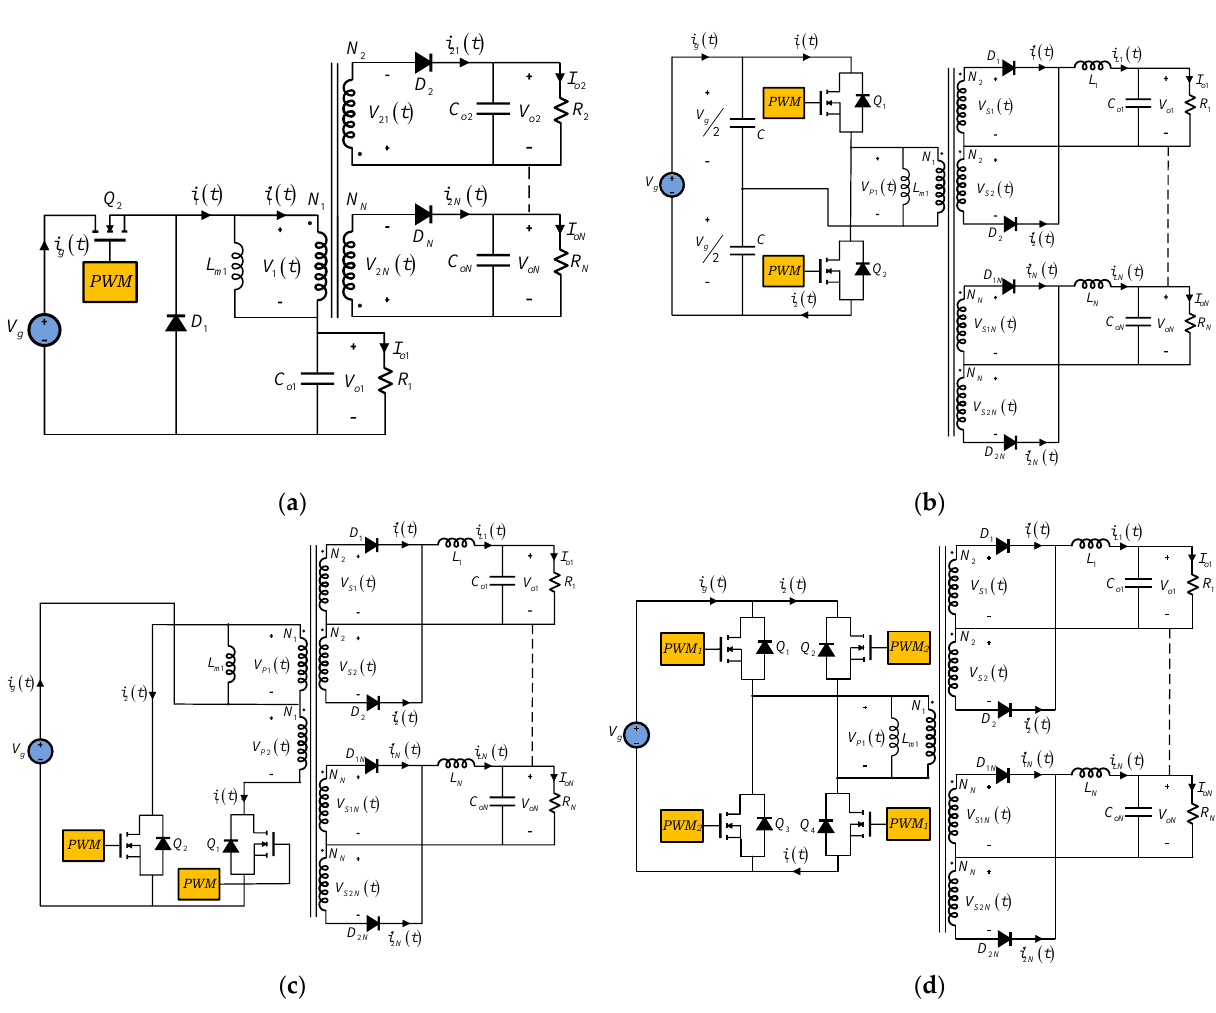
Figure 5. Multiple-Output Isolated DC – DC Converters Topologies. ( a ) Isolated Buck (Fly-Buck) Converter. ( b ) Half-Bridge Converter. ( c ) Push – Pull Converter. ( d ) Full-Bridge Converter.